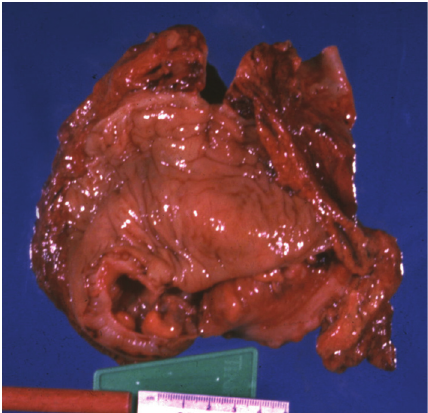
Figure 1: Abdominal X-ray demonstrating a cystic air-filled structure in the right upper quadrant.